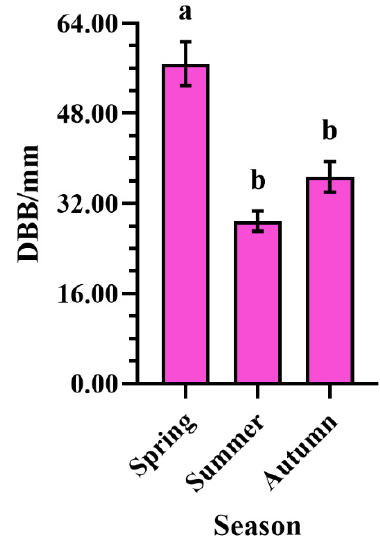
Fig 3 . Seasonal variation in distance ( DBB ) between base of swarm cell and bottom bar of movable